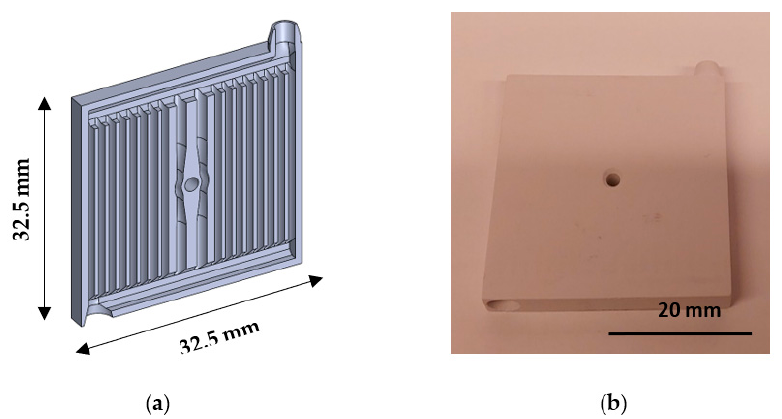
Figure 9. CAD substrate with integrated complex fluid channels: ( a ) sectional view of the CAD-design; ( b ) shaped component in the green state.